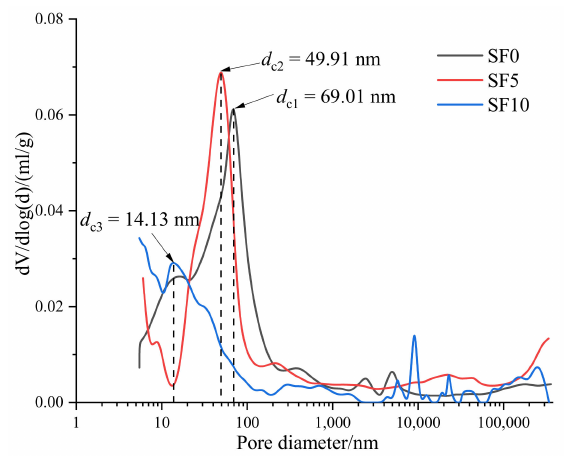
Figure 6. Pore size distribution measured by the MIP